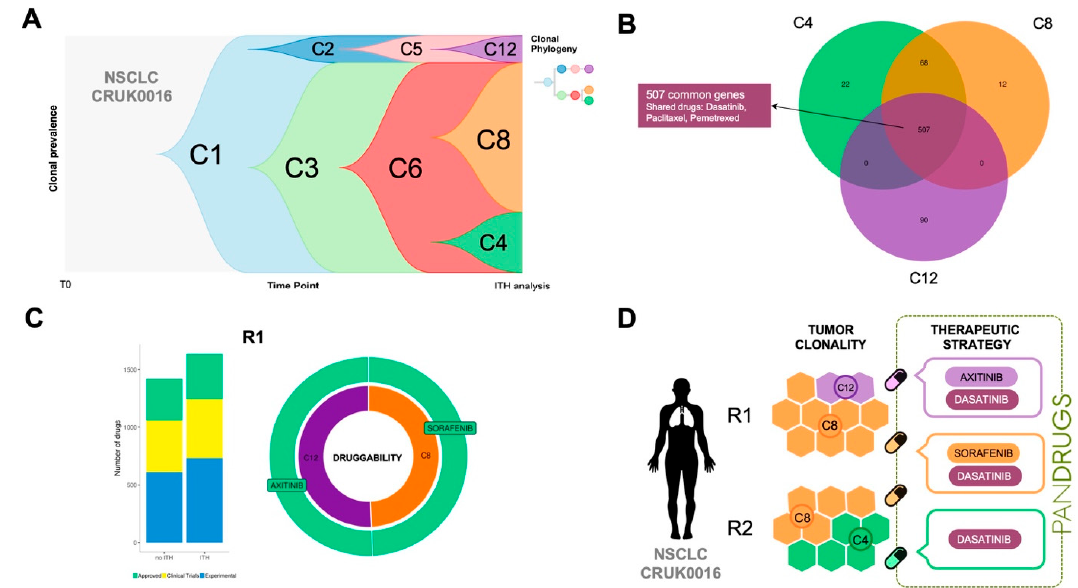
Figure 5. Analysis of the non-small cell lung cancer (NSCLC) patient CRUK0016. Two regions (R1 and R2) were sampled and three different clones (C4, C8 and C12) were detected. ( A ) Fishplot and clonal phylogeny of the evolution of tumoural cell populations. ( B ) Venn diagram of the mutated genes detected in the tumour subclones. PanDrugs proposed dasatinib, paclitaxel and pemetrexed to target the common genes among all clones (trunk). ( C ) Left: Number of therapeutic candidates revealed by bulk and intra-tumour Heterogeneity (ITH) analysis of R1. We assumed that bulk sequencing would only detect the predominant clone (C8). Drugs have been coloured according to their status. Right: Druggability and proposed therapies to treat the clones in R1. Druggability is defined as the percentage of different targetable genes in each subclone over the total targetable genes in a region. ( D ) Therapeutic regimen proposed to treat patient CRUK0016 based on PanDrugs predictions. Dasatinib could be used to target all clones simultaneously (trunk), while axitinib and sorafenib would target clone-specific mutations in C12 and C8 respectively. We did not find any good drug candidate (Drug Score > 0.70) to treat C4 individually. Thus, R1 could be treated with a combination of drugs targeting trunk mutations (dasatinib) and two subclone-specific drugs whereas R2 would be targeted with dasatinib and C8-specific treatment (sorafenib).